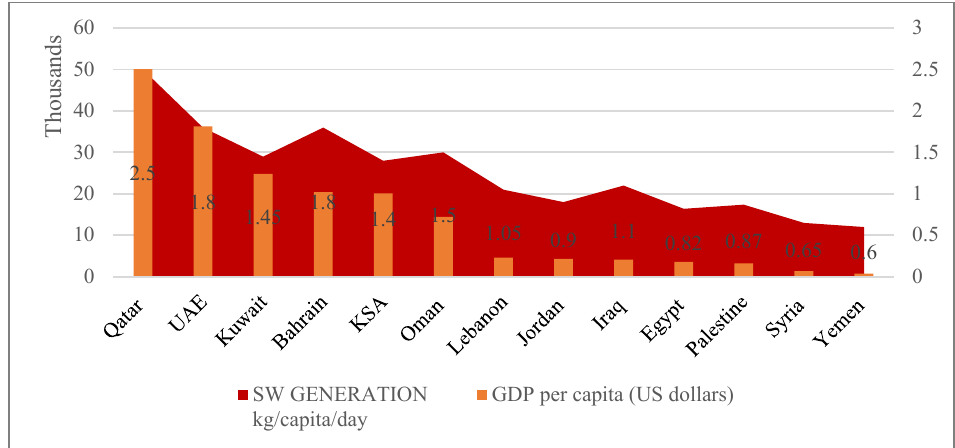
Figure 5. Waste generated in kg/capita/day and the GDP in US dollars/capita for each Arab country.